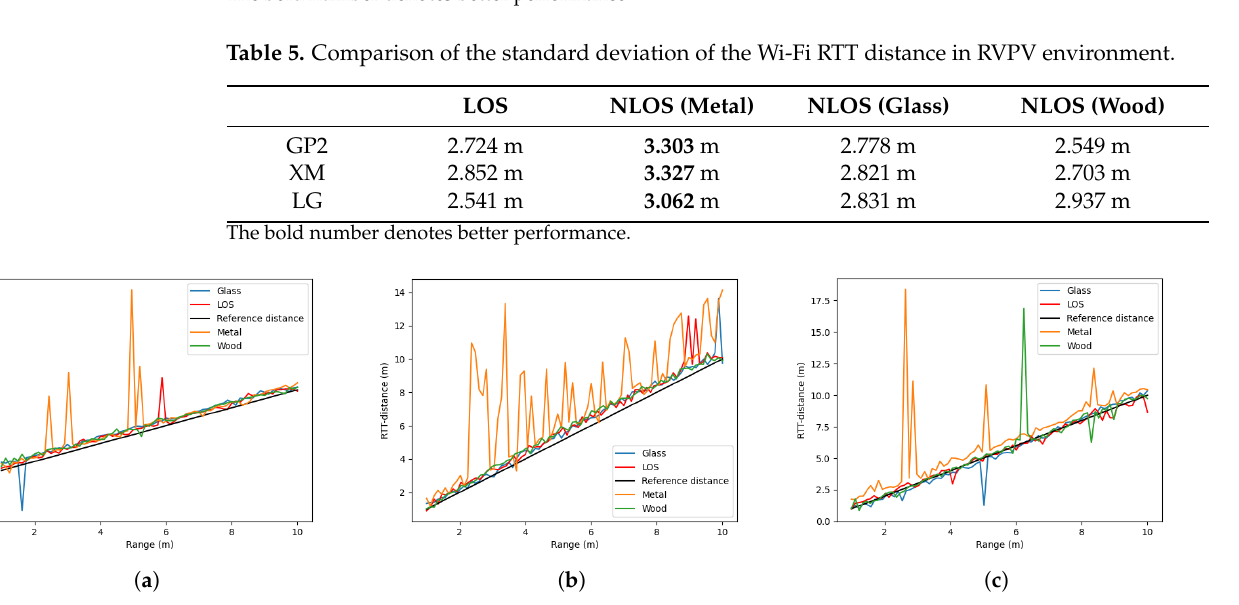
Figure 12. Wi-Fi RTT distance in RVPV: ( a ) Wi-Fi RTT distance from Google Pixel 2; ( b ) Wi-Fi RTT distance from Xiaomi Redmi K20; ( c ) Wi-Fi RTT distance from LG